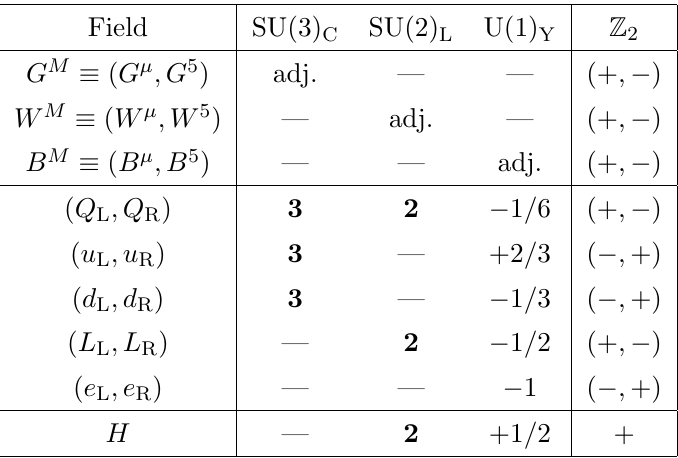
Table 1 . Field content of the minimal universal extra dimension (MUED) model and their gauge and Z 2 quantum numbers. The Latin index M indicates a 5D Lorentz index, M = 0 ; 1 ; 2 ; 3;